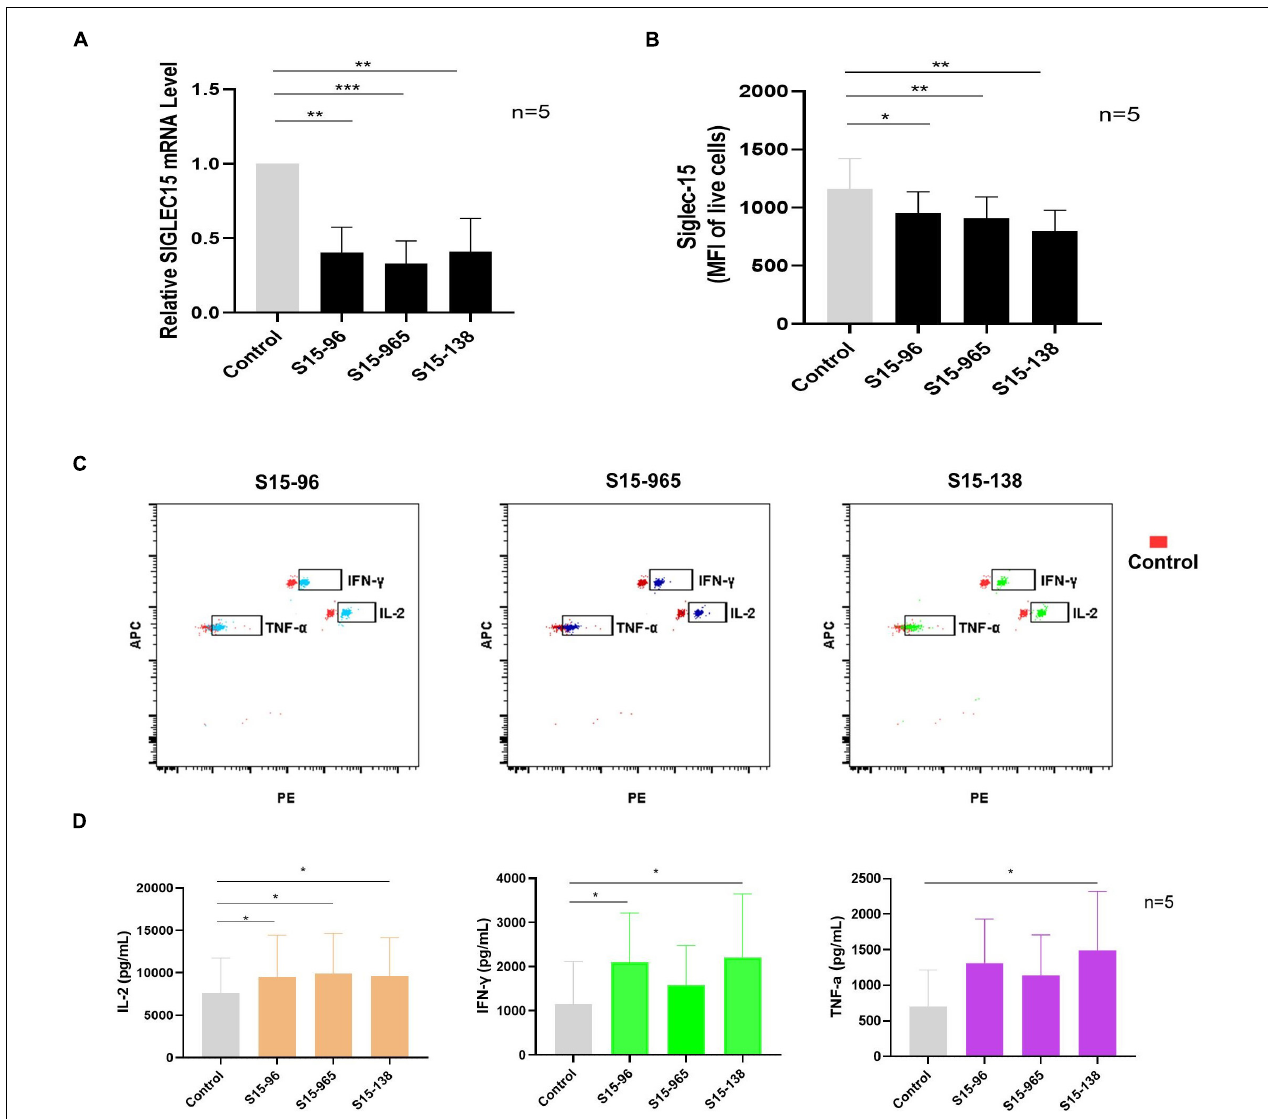
FIGURE 6 | Silencing SIGLEC15 restores the anti-tumor ability of T cells in SNs. (A) RT-PCR analyses of SIGLEC15 mRNA expression in five cases of SN cells treated with control siRNA (control) or SIGLEC15 -siRNA (S15-96, S15-965, and S15-138). (B) Flow cytometry analyses of Siglec-15 protein expression in five cases of SN cells treated with control siRNA (control) or SIGLEC15 -siRNA (S15-96, S15-965, and S15-138). (C) Graphical representation of LEGENDplex assay of cytokine expression in control and SIGLEC15 -siRNA-treated SN cells. (D) Quantification of cytokines in the supernatants 72 h after SIGLEC15 -siRNA silencing in SN cells. * p < 0.05, ** p < 0.01, and *** p < 0.001, with paired t